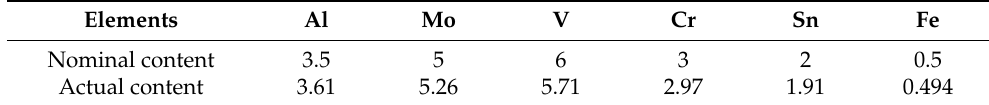
Table 1. The chemical composition of Titanium ingots